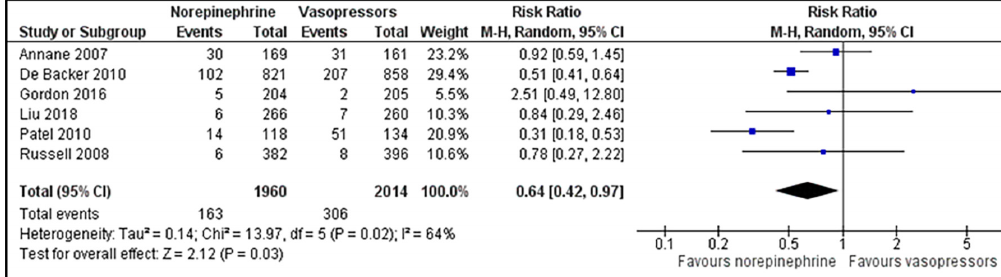
Figure 4 . Comparison between norepinephrine and vasopressors for the outcome of the incidence of arrhythmia. M-H, Mantel-Haenszel method; CI, confidence